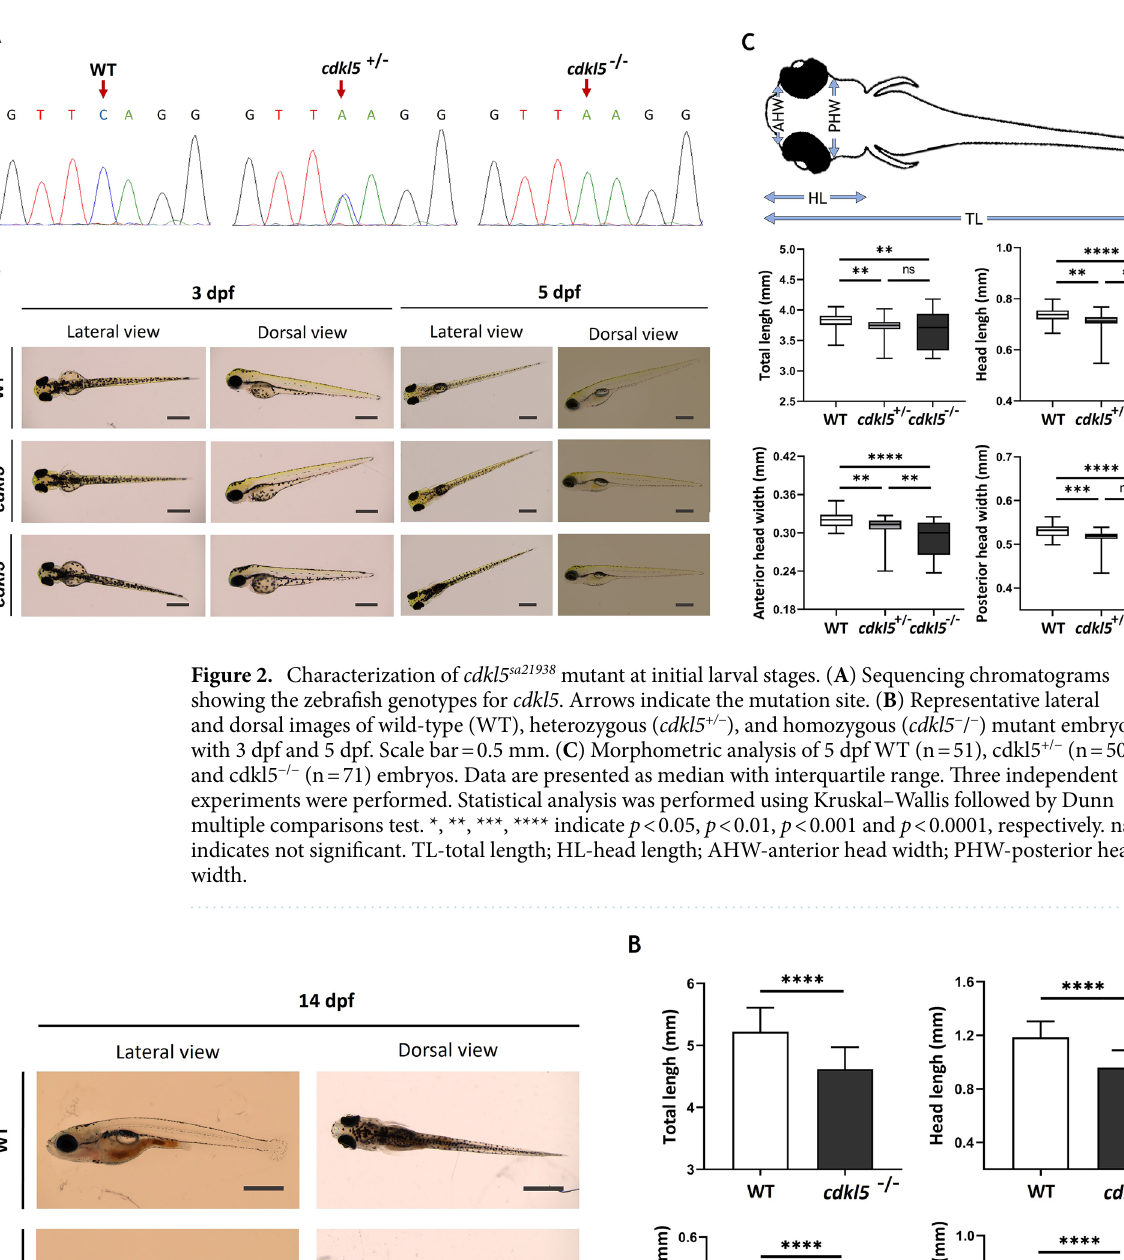
cular swimming motion followed by a series of brief clonus-like convulsions 18 was observed in WT, cdkl5 +/− and